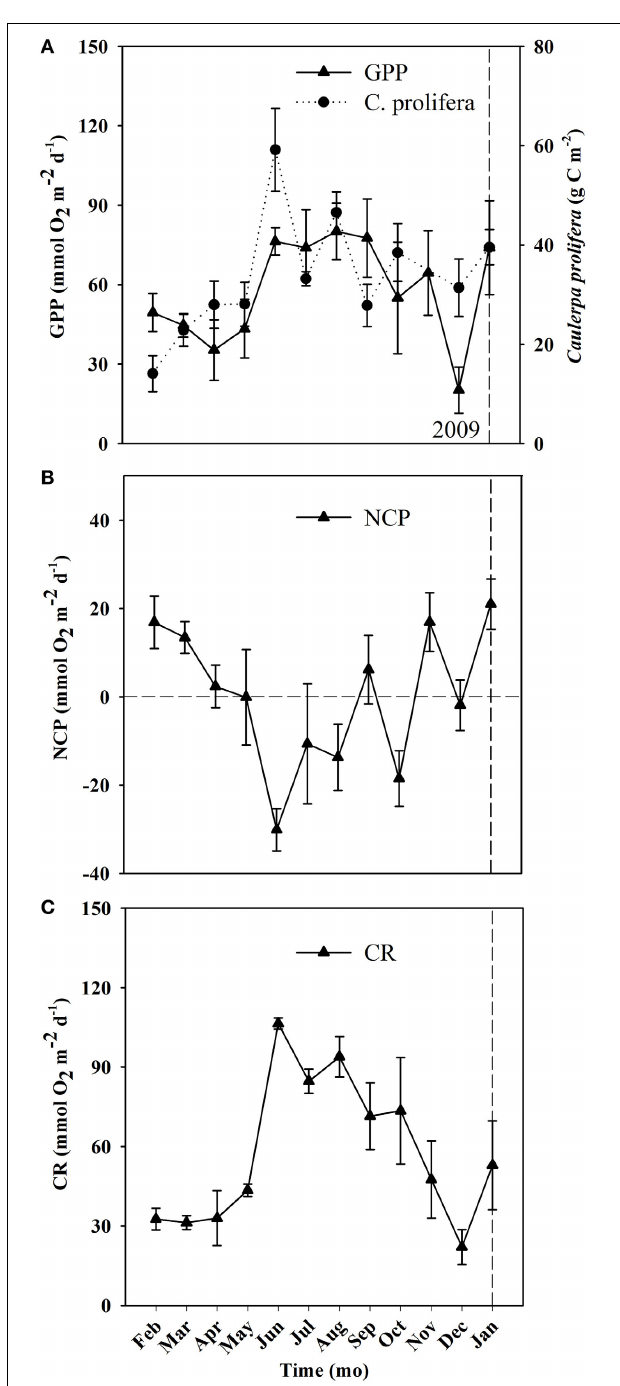
FIGURE 5 | Temporal changes in community metabolism (GPP, CR, and NCP) and C. prolifera biomass derived from the cores used to calculate metabolic rates in the Bay of Portocolom over the course of the study. Mean ± S.E. Panel (A) represents GPP (gross primary production, closed triangles, full line) and Caulerpa prolifera biomass (closed circle, dashed line). Panel (B) represents NCP (net community production) and Panel (C) represents CR (community respiration). The horizontal dashed line marks NCP = 0 (i.e., metabolic balance). The vertical dashed line represents the change of year from 2009 to